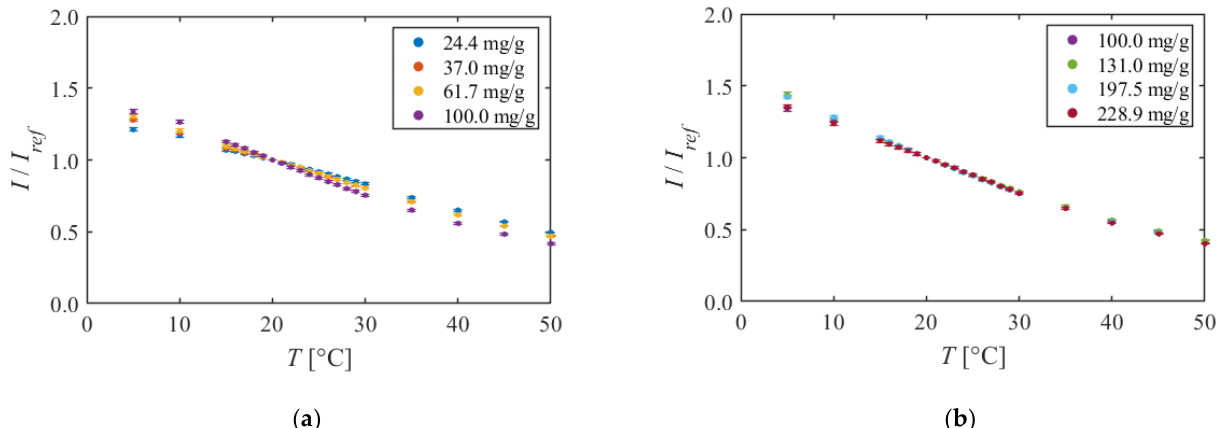
Figure 4. Calibration curves of PAA + EtOH in different dye concentrations. The reference condition is T = 20 °C and P = 100 kPa. ( a )The dye concentration is 100 mg/g or less. ( b )The dye concentration is 100 mg/g or more.